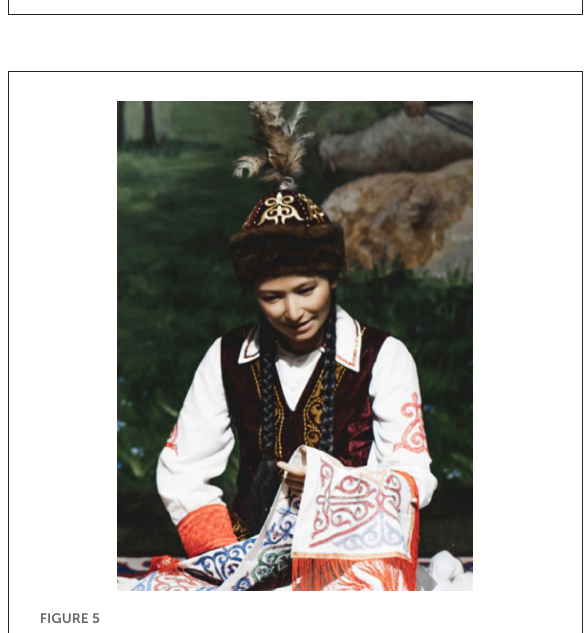
FIGURE5 Swan totem